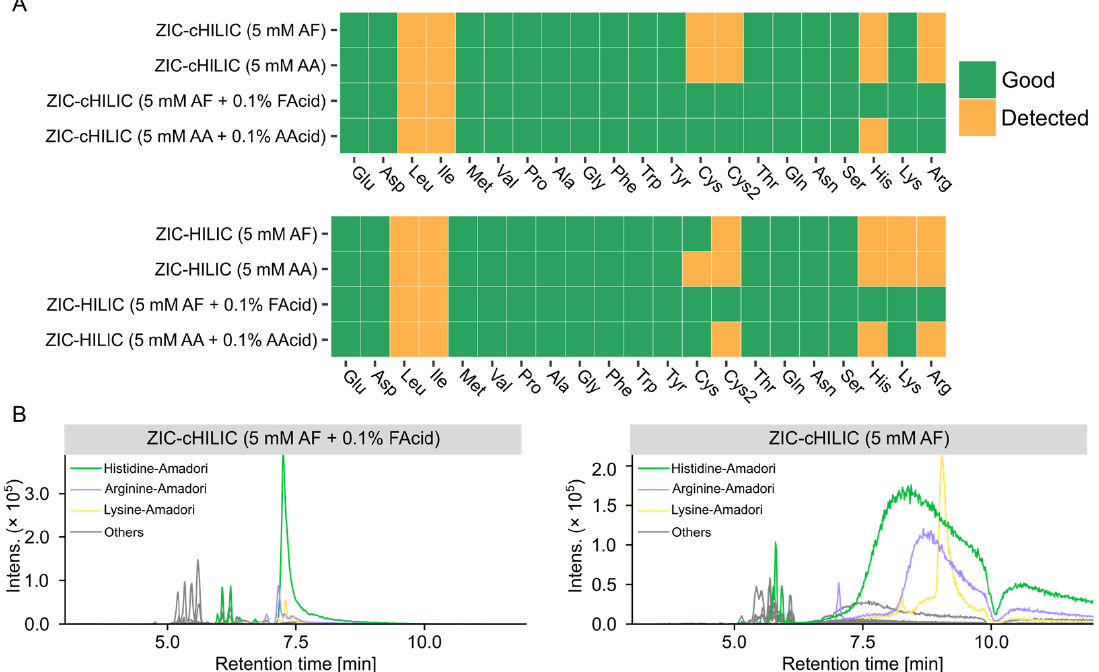
Figure 5. Effects of mobile phase on peak shapes of the amino acids and ARPs. ( A ) Individual score of amino acids analyzed by different mobile phases. ( B ) Extracted ion chromatograms of all 21 ARPs under acidic and neutral conditions (extracted with theoretical [M + H] + ± 0.005 Da, detailed information of theoretical m/z is shown in Table S6).